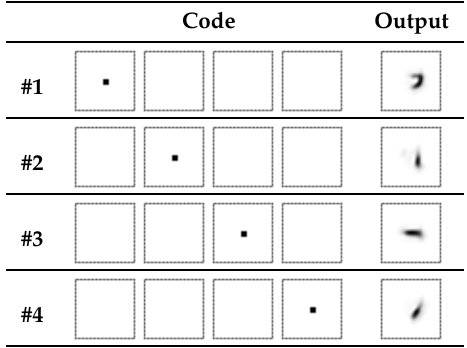
Table 10. AF4 decoder results for synthetic encoding, where only one point is activated.